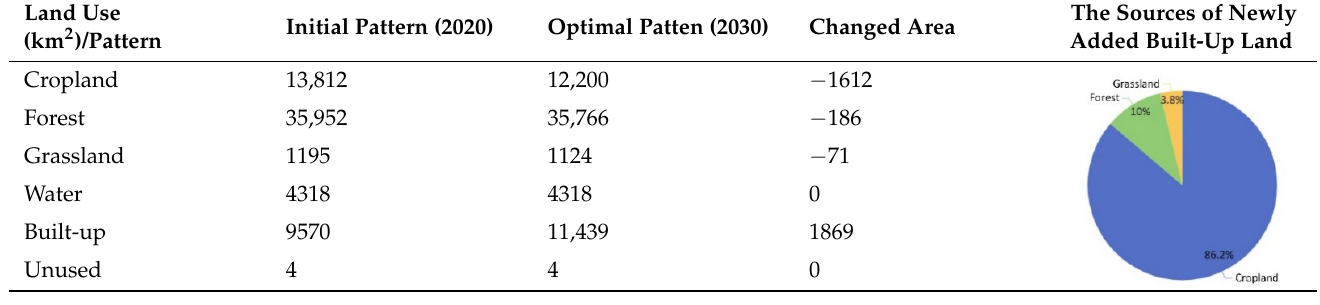
Table 4. Quantity structure of the GBA in 2030.